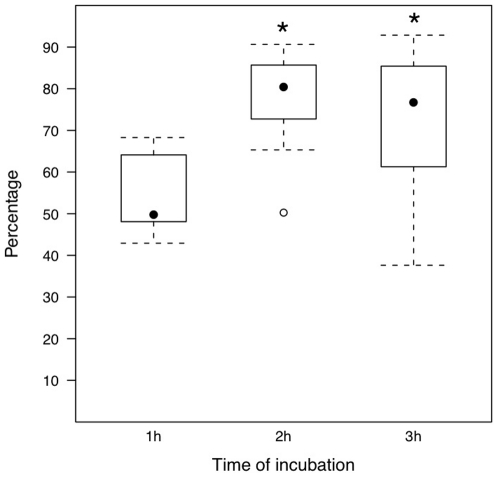
Effect of incubation on percentage of sperm with active caspases.Distribution of the percentage of sperm expressing active caspase-3 and -7 detected in ejaculated sperm after one, two, or three hours of incubation. Values are medians (solid circle) with 25–75% interquartile ranges (box); dotted vertical lines indicate minimum and maximum values; open circle indicate outlier. Values of five replicates. * P<0.05 vs one hour.